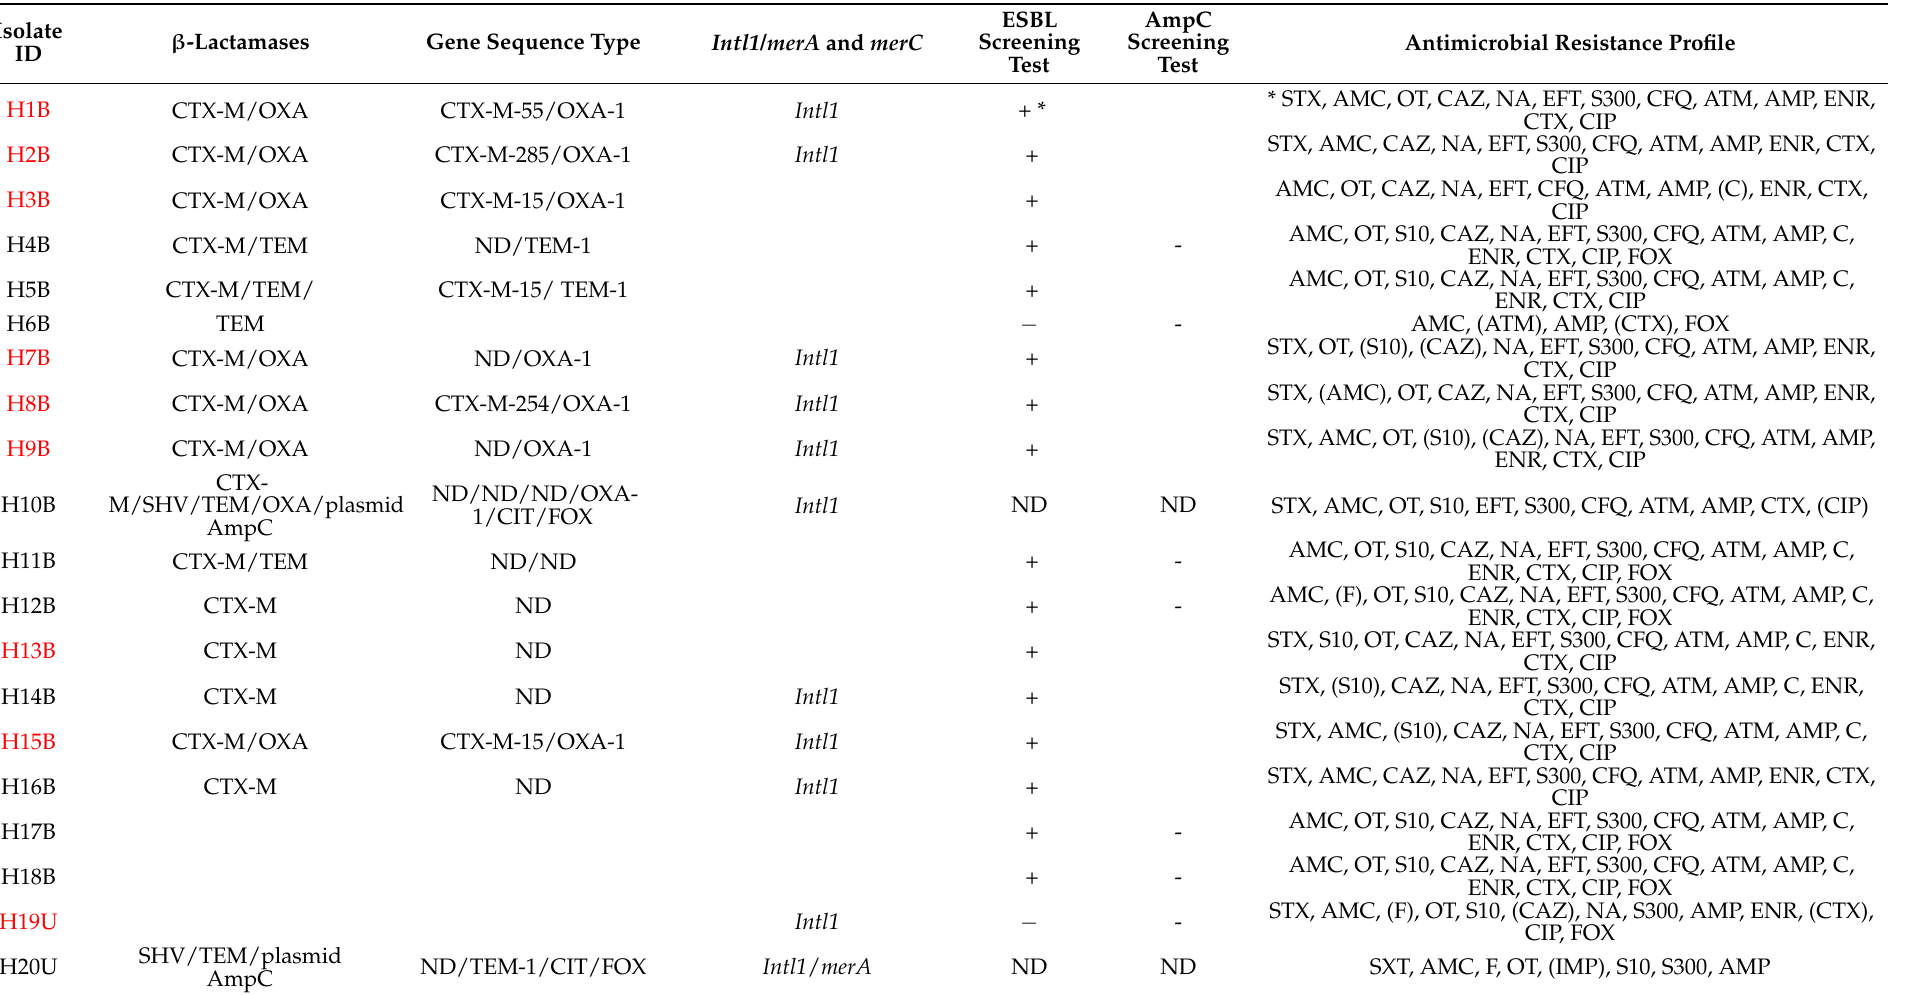
Table 1. Isolates with β -lactamase genes, Intl1 , merA and merC , the phenotypic results of ESBL/AmpC screening and their phenotypic resistance patterns for different